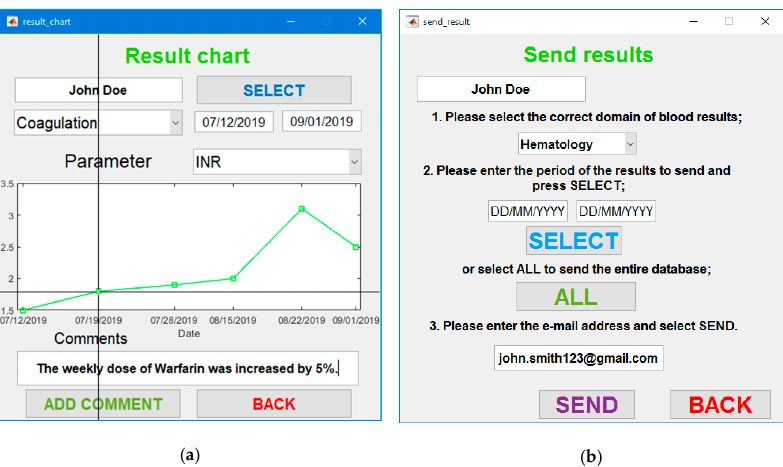
Figure 7. The LabConcept’s interface for accessing and sending the results: ( a ) The graphical representation of the stored results over a user predefined period of time, including the clinical comments; ( b ) The sending interface for the results contained in the database via e-mail.